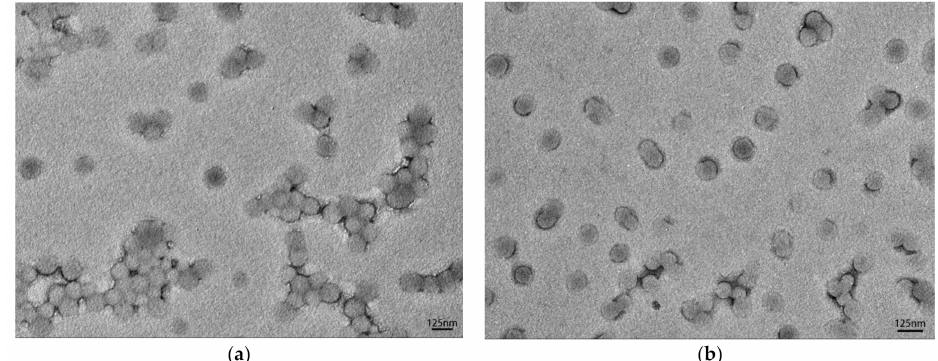
Figure 3. TEM images of the final latexes for lignin-based hybrid acrylate latex ( a ) and pure MMA- co -BA ( b ).